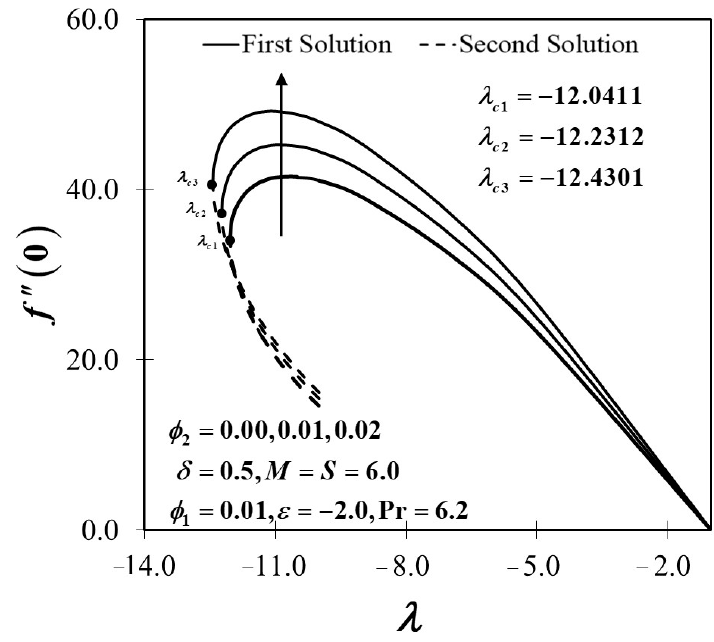
( ) 0 f ′′ against λ by various